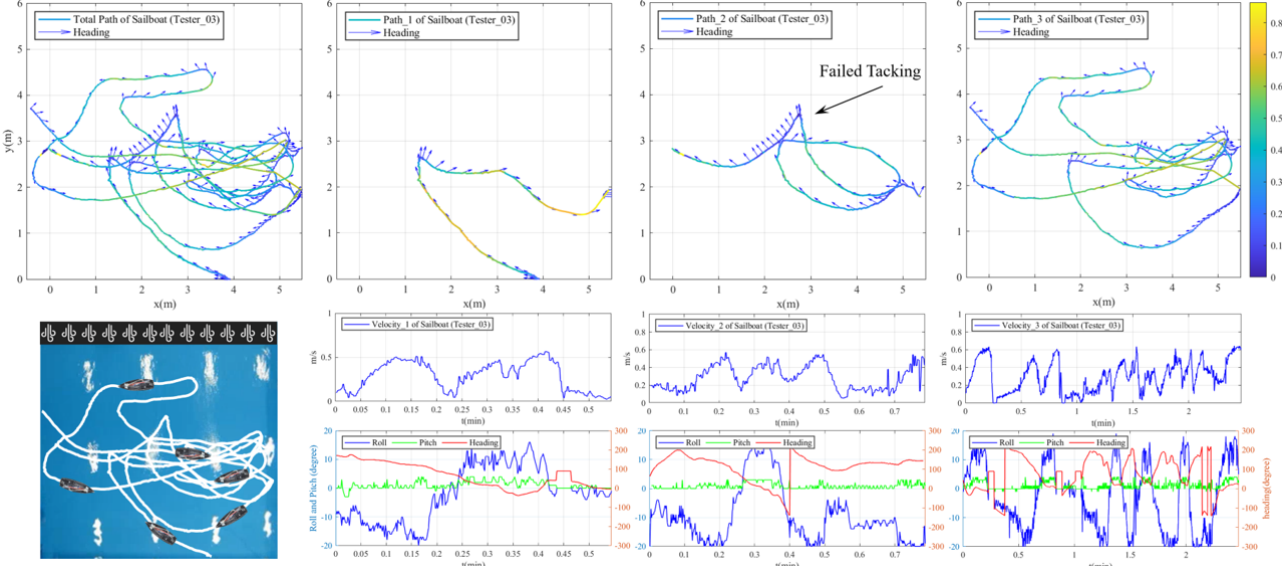
Figure 11. Remote sailing test (tester 03) in STAr. The content contained in the figure and its ordering correspond to that of tester 01 &